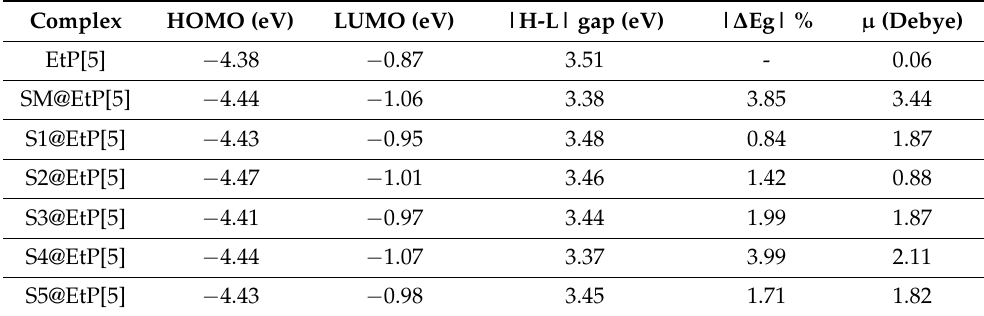
Table 3. Calculated chemical parameters for EtP[5] and all complexes using r 2 SCAN-3c in the gas